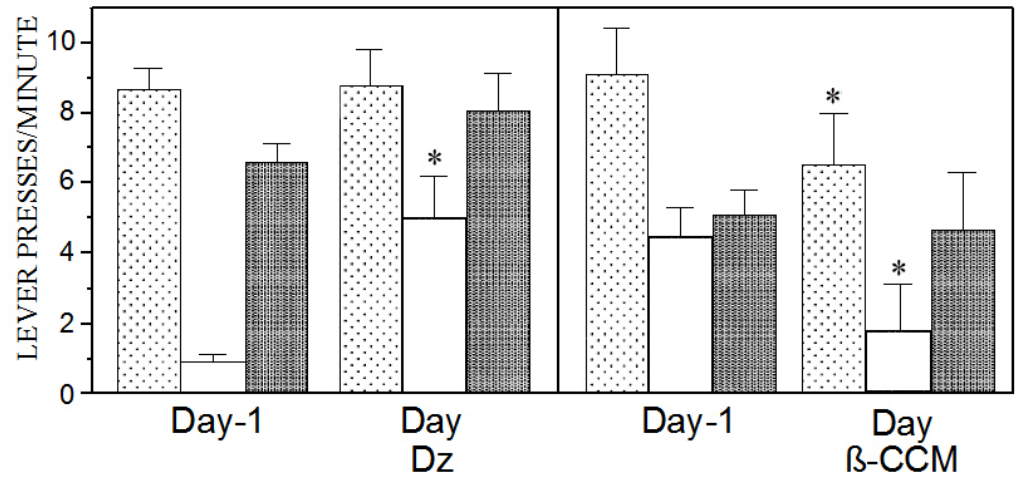
FIGURE 3. Treated mice (diazepam, beta-CCM) in a conflict situation . The middle column of each group of three is the conflict situation, i.e., with electric shock, while the first and third columns are the nonconflict, positively reinforced sessions, without electric shock. With a moderately high electric shock conflict situation, there was a sharp increase in lever pressing by mice after administration of diazepam (DZ), when compared to the previous day (left, middle white column), providing evidence of the anxiolytic effect of diazepam. With a milder electric shock conflict situation, there was a sharp drop in lever pressing after administration of beta-CCM ( β -CCM), compared to the previous day without treatment, thus providing evidence of an anxiogenic effect of diazepam. For other significant effects, see Prado de Carvalho et al.[46]. (Adapted from Prado de Carvalho et al.[46].)